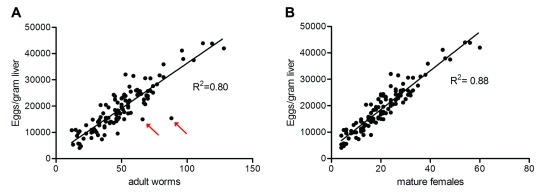
The number of eggs per gram of liver correlates with the number of adult worms.(
A) For each group of immunised animals, the average number of eggs per gram of liver was plotted against the average number of
S. mansoni worms per animal recovered after perfusion. A high correlation (R
2 = 0.80) was observed between the two measurements. Red arrows indicate groups of animals immunised with proteins 98 and 100, in which a marked deficit in the number of eggs compared to the total number of adult worms was observed. This was attributed to a sex ratio imbalance in the cercarial preparation used for the infection challenge, resulting in an excess of (mostly sexually immature) female worms. Across all groups of animals tested, variability in parasite recovery ranged from 6 to 64%, reflecting the heterogeneity in the cercarial preparations used to infect the different cohorts of animals. (
B) For each group of immunised animals, the average number of eggs per gram of liver was plotted against the average number of mature female worms per animal recovered after perfusion. A high correlation was observed between both measurements (R
2 = 0.88).